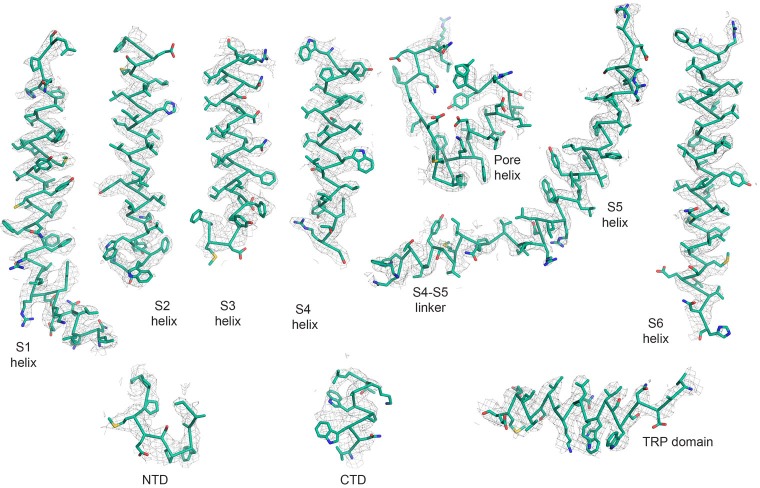
Representative densities from the TRPV2CBD_1 cryo-EM map.Densities are contoured at σ = 5.